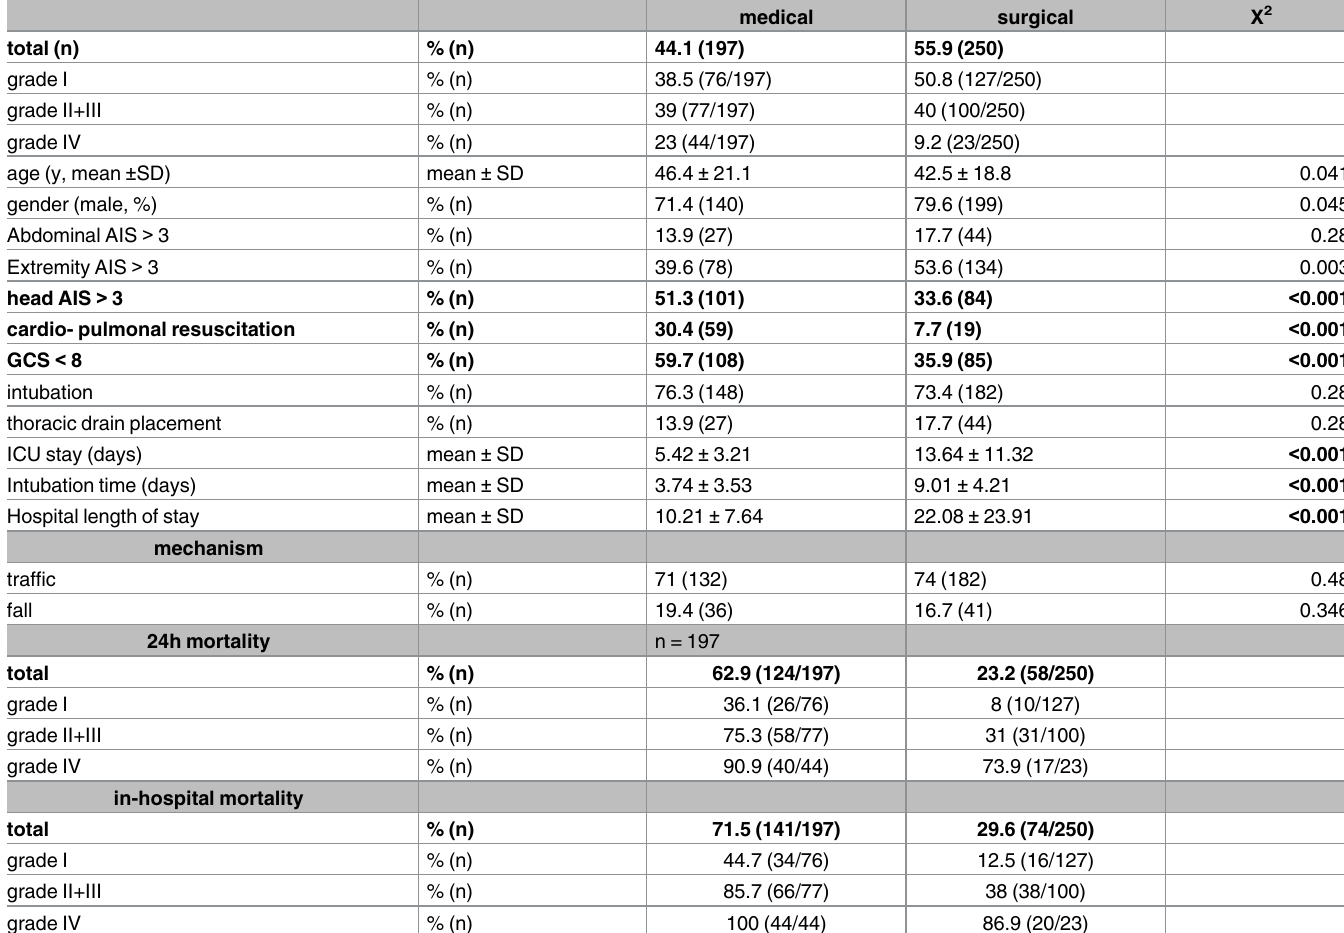
Table 2. Comparison of the conservative and surgical treatment subgroup.